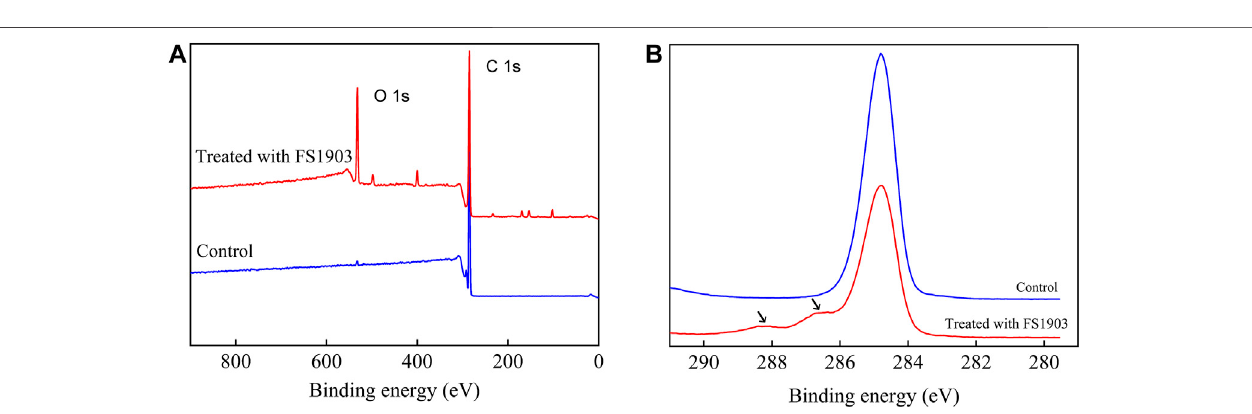
FIGURE 7 | XPS scanning (A) and C1s spectra (B) of the control and the residual PS fi lms inoculated with FS1903.